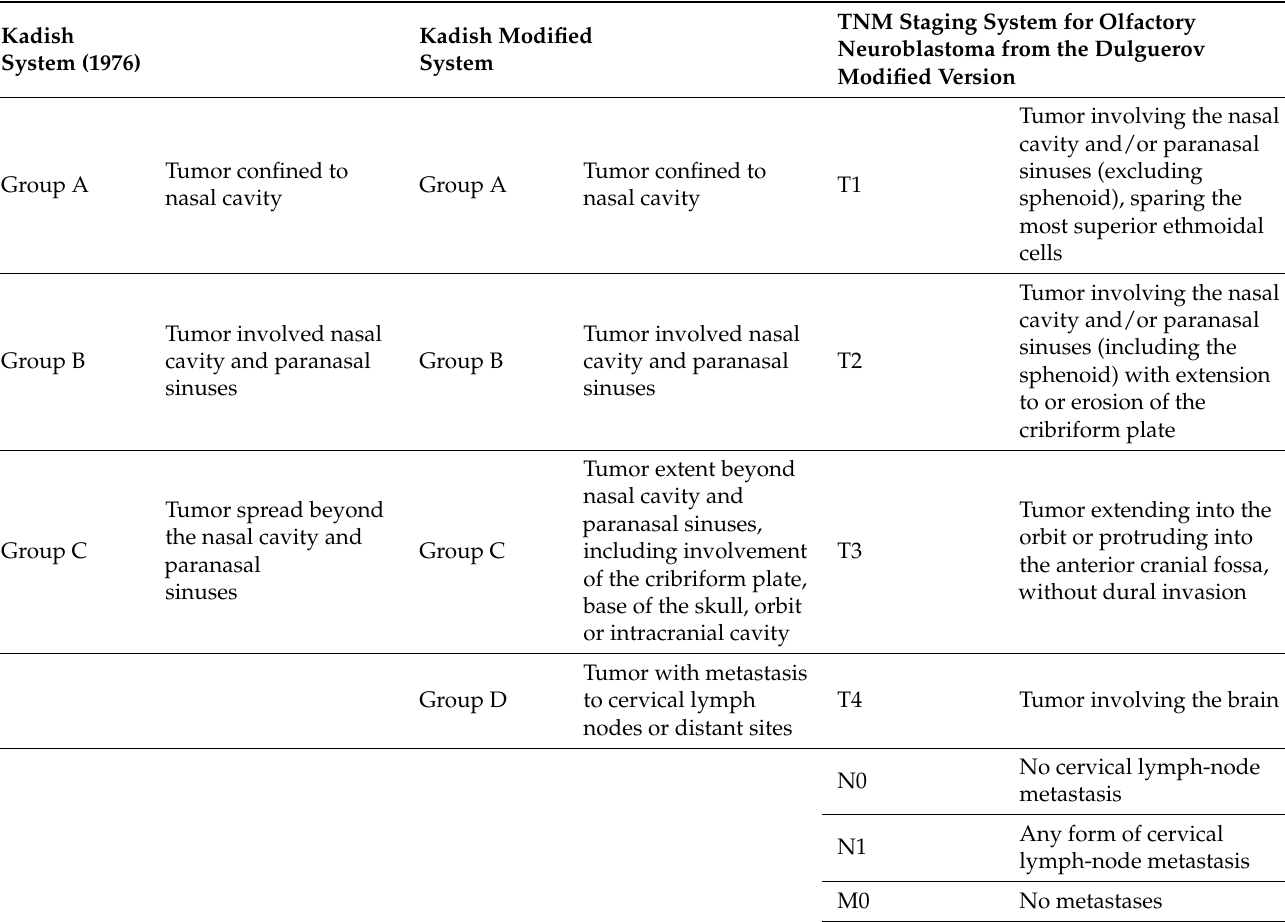
Table 1. Staging systems for olfactory